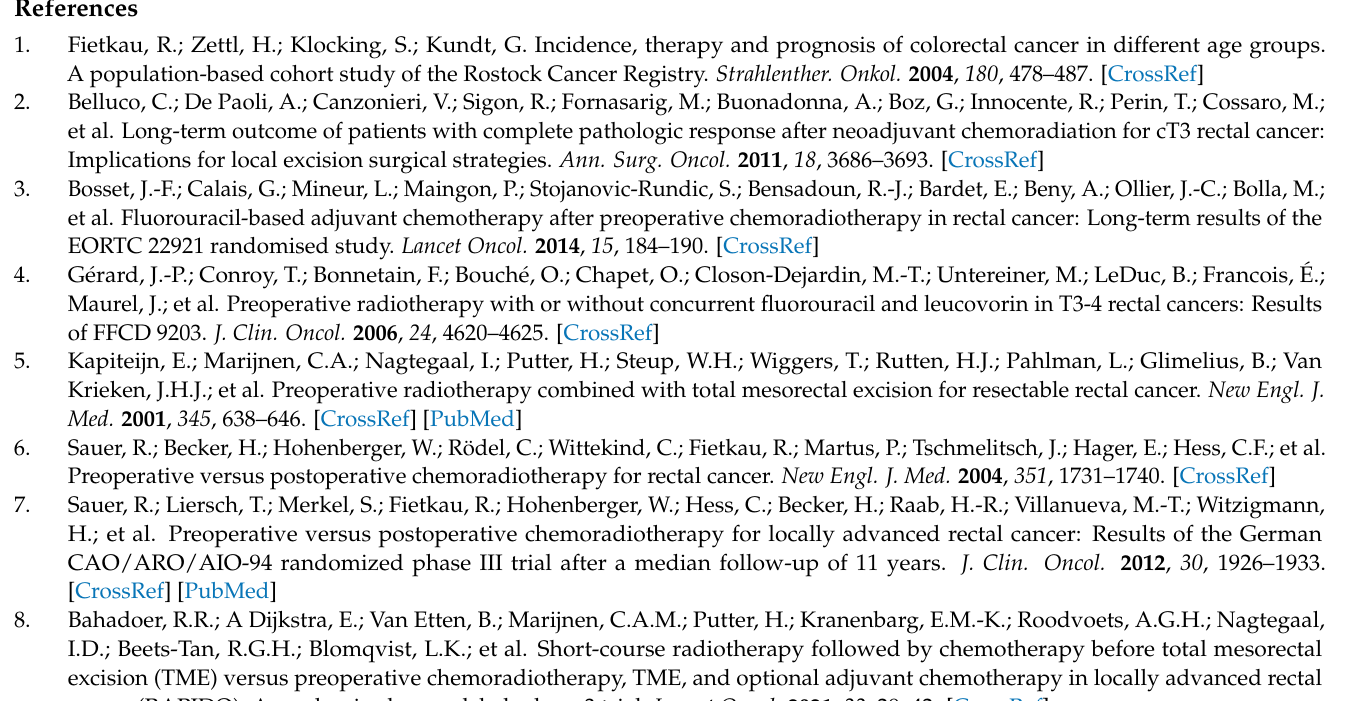
Figure S3: CSS in dependence on the OGG1 rs1052133 polymorphism stratified by post-surgery ypN status. Figure S4: Micronuclei rate in patient leucocytes during the time course of N-RCT stratified by OGG1 rs1052133. Figure S5: Radiosensitivity of lymphoblastoid cell lines in dependence on OGG1 rs1052133. Table S1: Primer sequences for multiplex PCR and polymorphic sites assayed. Table S2: List of employed lymphoblastoid cell